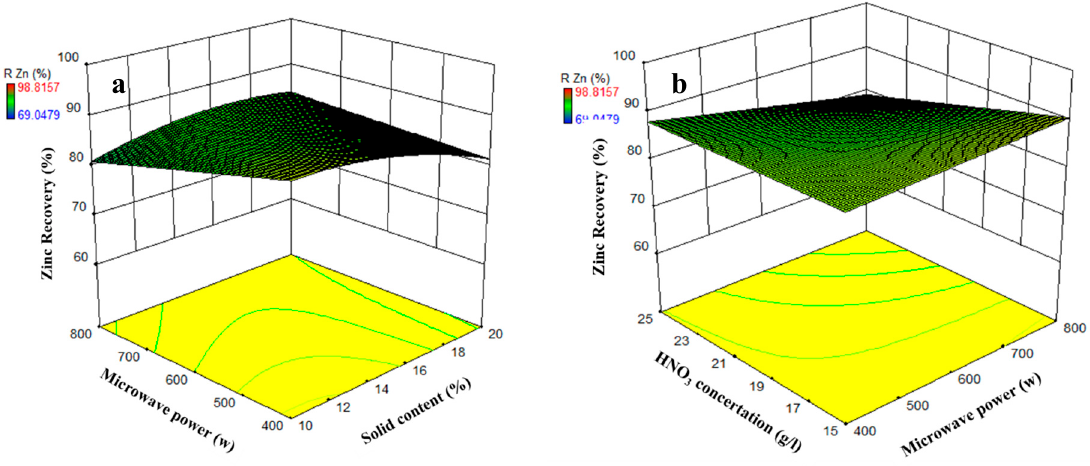
Figure 8. The Microwave power-solid content ( a ) and HNO 3 concentration-microwave power ( b ) interactions (other parameters are held at center level).